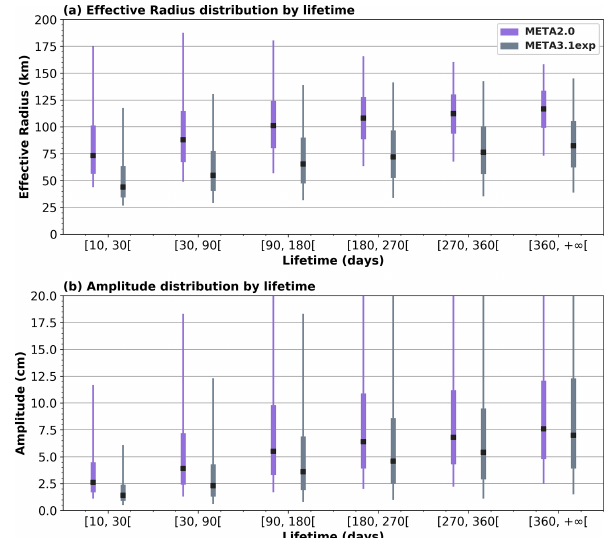
Figure 10. Distribution of (a) effective radius and (b) ampli- tude for different lifetimes for the META2.0 eddies (purple) and META3.1exp eddies (gray). The black squares mark the median, the thick lines span from the 25th to the 75th percentiles, and the thin lines from the 5th to the 95th percentiles of the